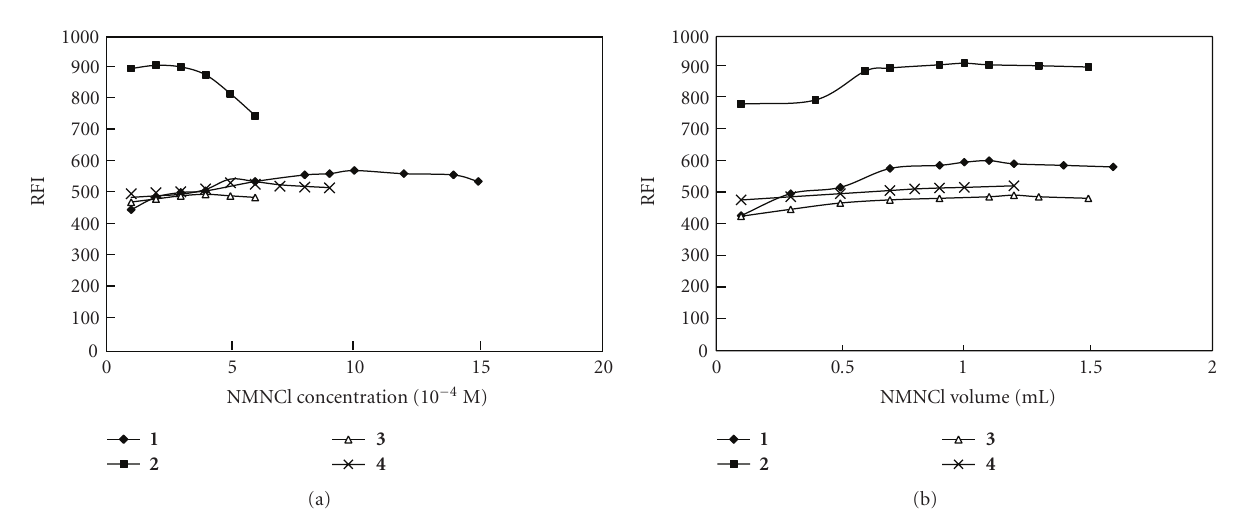
Figure 3: E ff ect of NMNCl concentration and volume on fluorescence intensity of the reaction product of 1–4 with NMNCl. The variation of NMNCl concentration is made at constant volume and that of NMNCl volume at constant concentration.